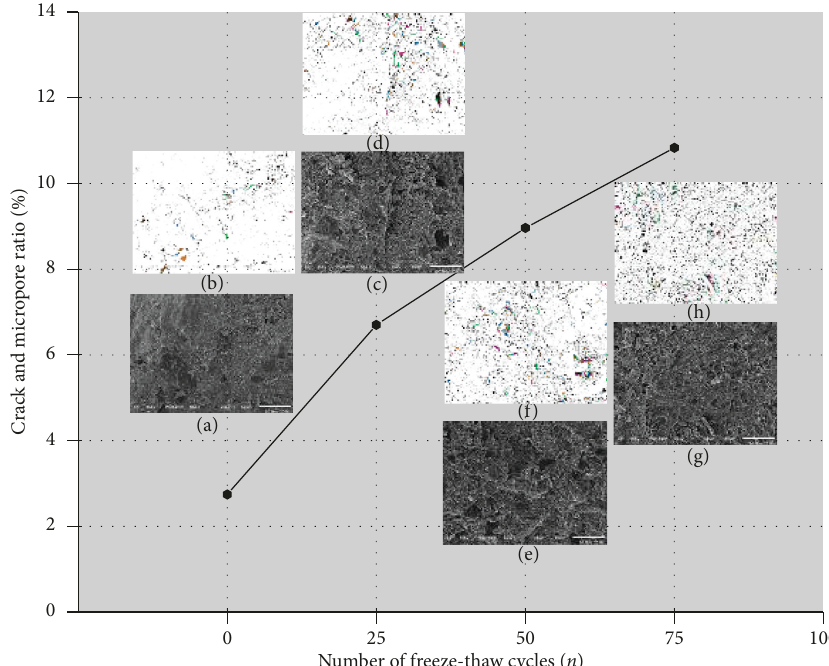
Figure 1: Micropore structure growth behavior for specimen (SEM 500x). (a) FTC00. (b) Binary diagram for FTC00. (c) FTC25. (d) Binary diagram for FTC25. (e) FTC50. (f) Binary diagram for FTC50. (g) FTC75. (h) Binary diagram for FTC75.